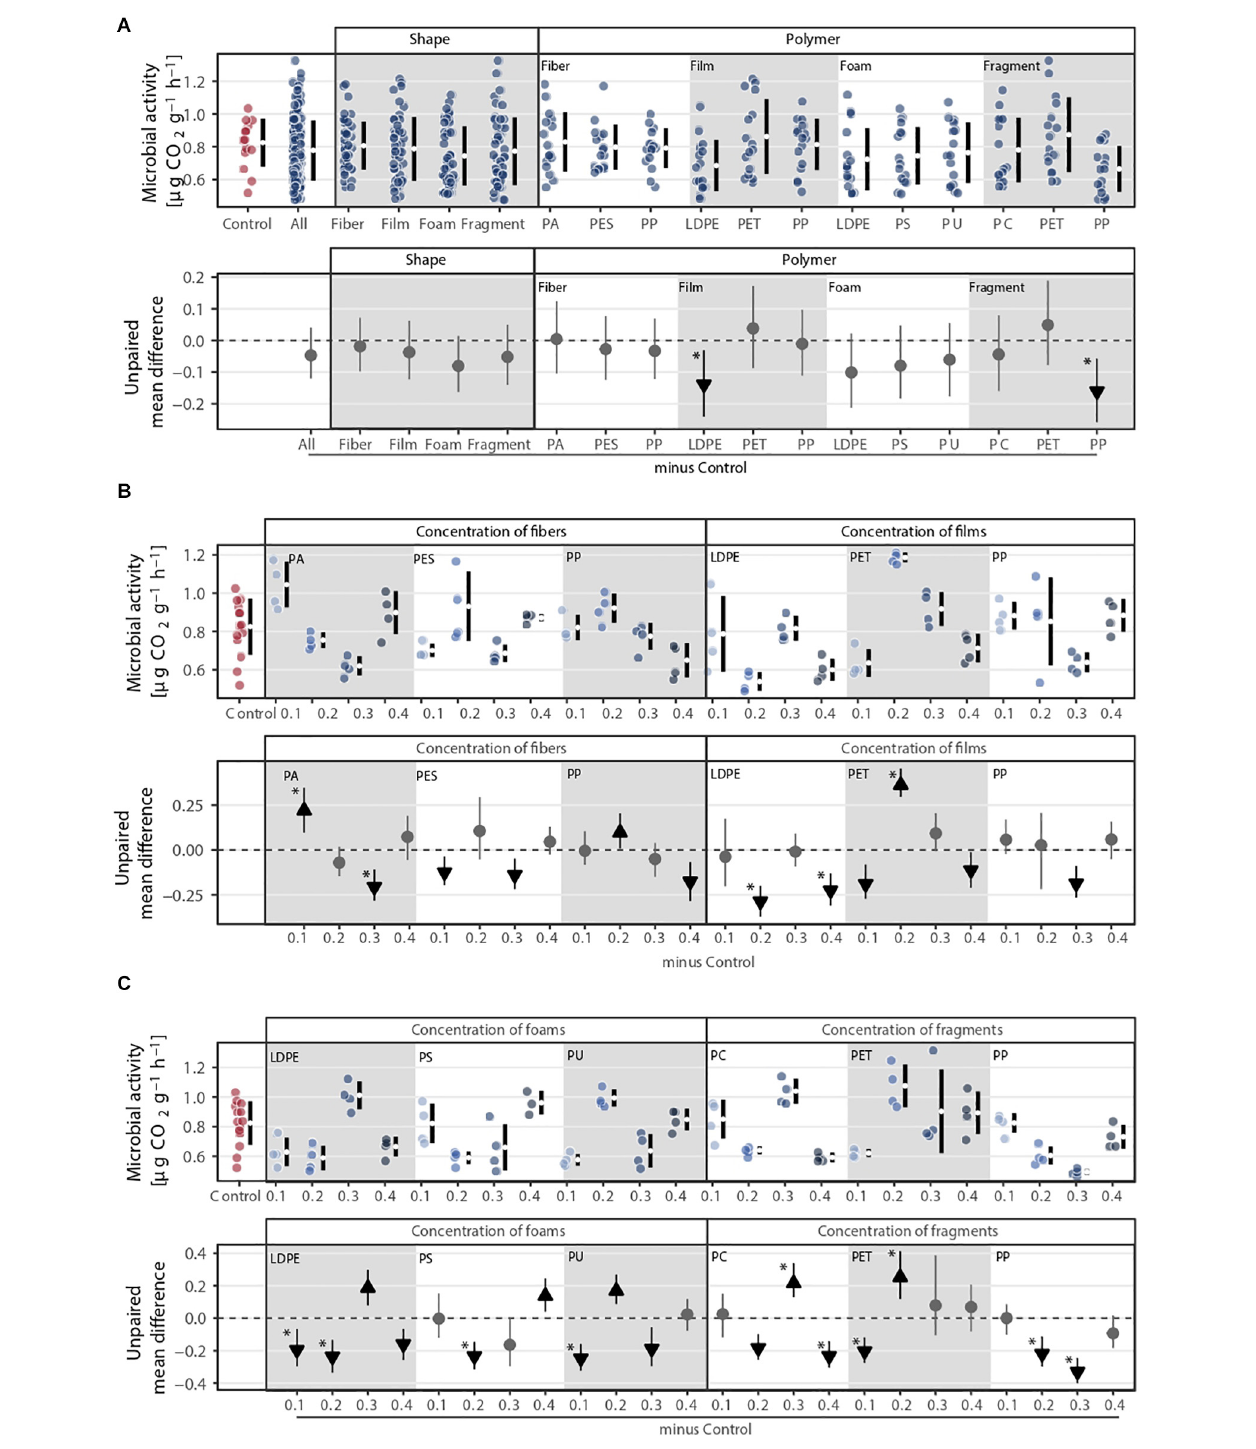
FIGURE 5 | Microbial activity (i.e., respiration) response to (A) microplastic shape and polymer type at (B–C) different concentrations (0.1, 0.2, 0.3, and 0.4%). That is, (B) concentration of fibers and films and (C) concentration of foams and fragments. Effect sizes and their variance are displayed as means and 95% confidence intervals. Effects are color-coded: gray circles indicate neutral effect sizes and black arrows with an arrow head pointing upward or downward indicate positive or negative effects, respectively. Horizontal dotted line indicates the mean difference value between each microplastic and the control. Polymers: PA (polyamide), PES (polyester), PP (polypropylene), LDPE (low density polyethylene), PET (polyethylene terephthalate), PS (polystyrene), PU (polyurethane), and PC (polycarbonate). Significance was established at 0.05 ( Supplementary Tables S1–S3 ); n = 7 for microplastics, n = 14 for control samples.